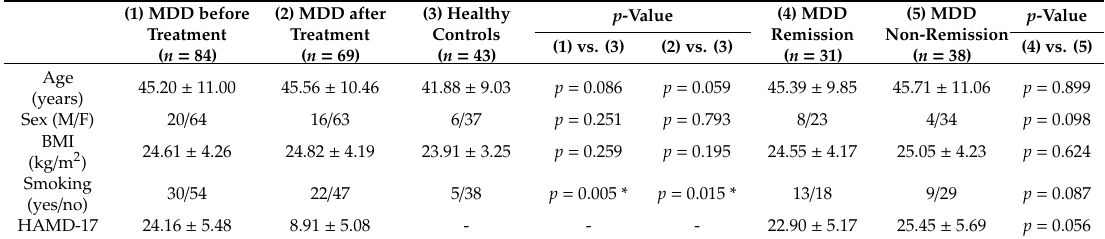
Table 1. Demographic and clinical characteristics of patients with major depressive disorder and healthy controls. MDD—major depressive disorder; M—male; F—female; BMI—body mass